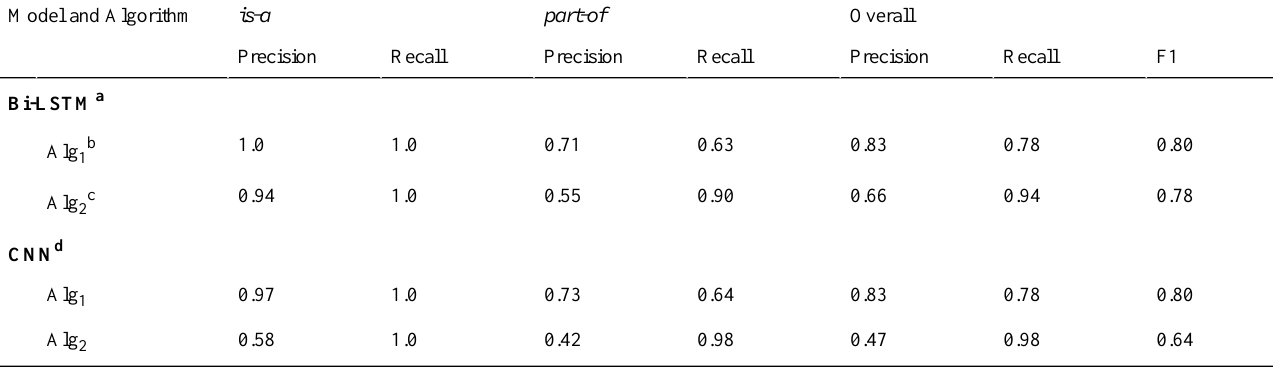
Overall part-ofis-a Model and